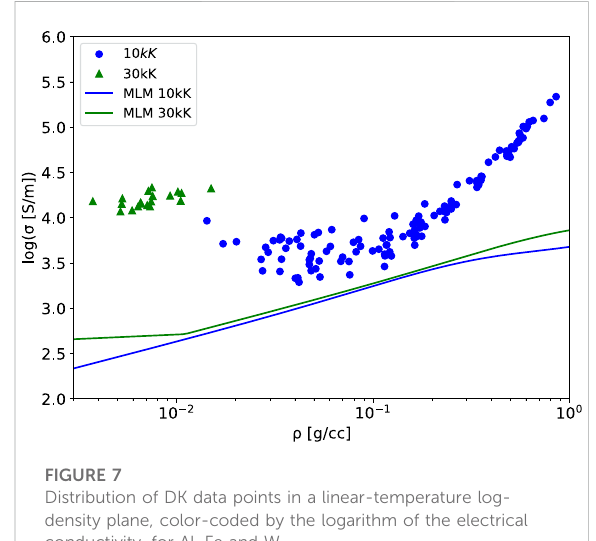
FIGURE 7 Distribution of DK data points in a linear-temperature log- density plane, color-coded by the logarithm of the electrical conductivity, for Al, Fe and W.